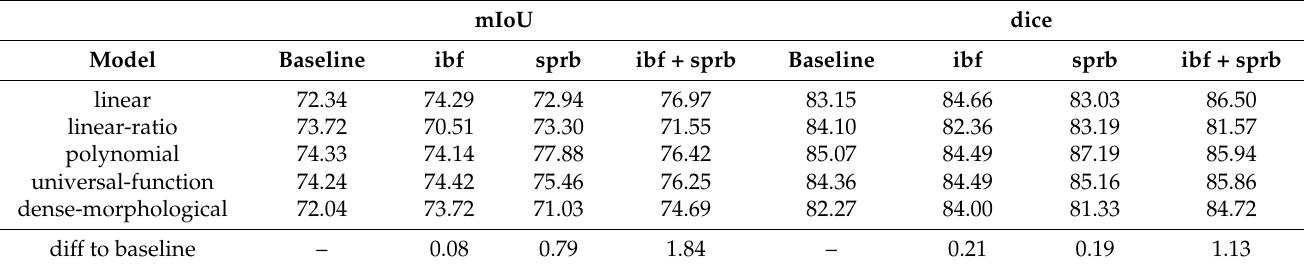
Table 7. Scores of DeepIndices in different modalities for a kernel size of 1 without initial image processing mIoU dice